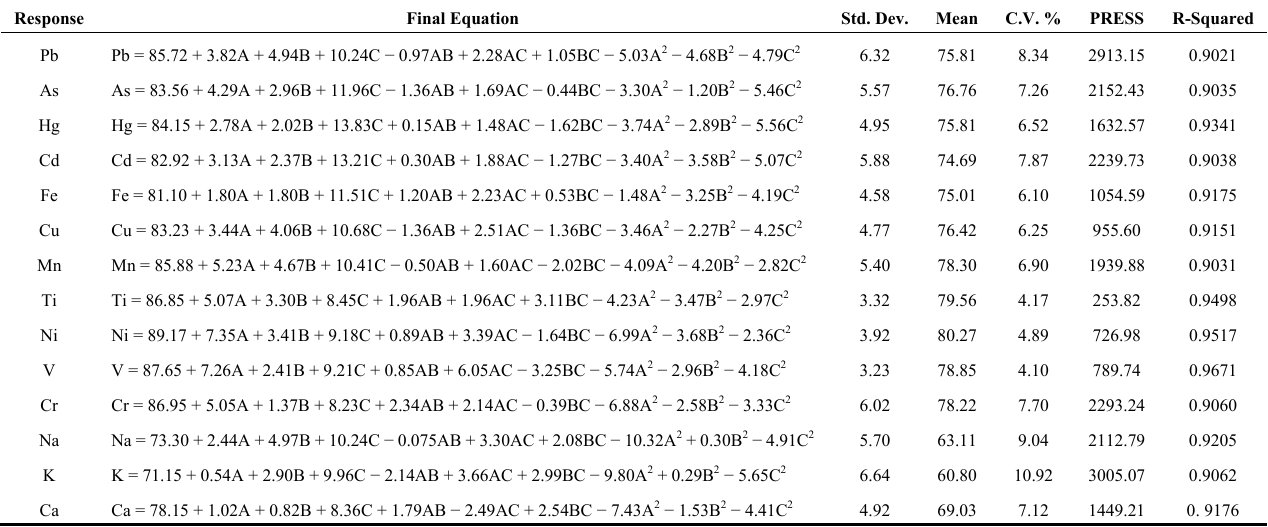
Table 2. ANOVA for response surface